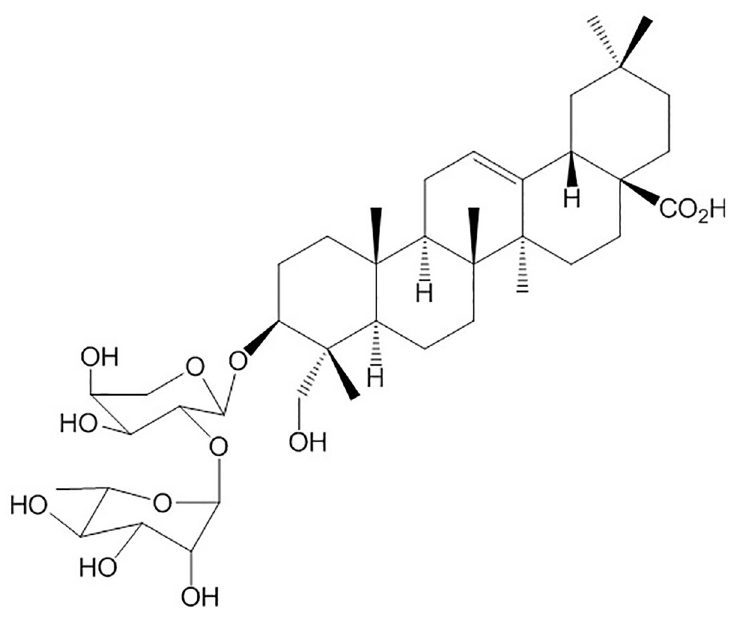
Fig 1. The structure of